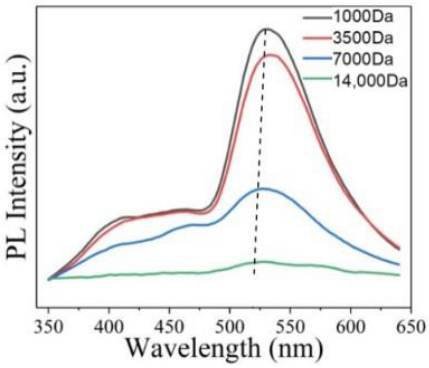
Figure 9. PL spectra of four separated quantum dots excited at 330 nm. Reprinted with permission from [50]. Copyright 2021, MDPI.